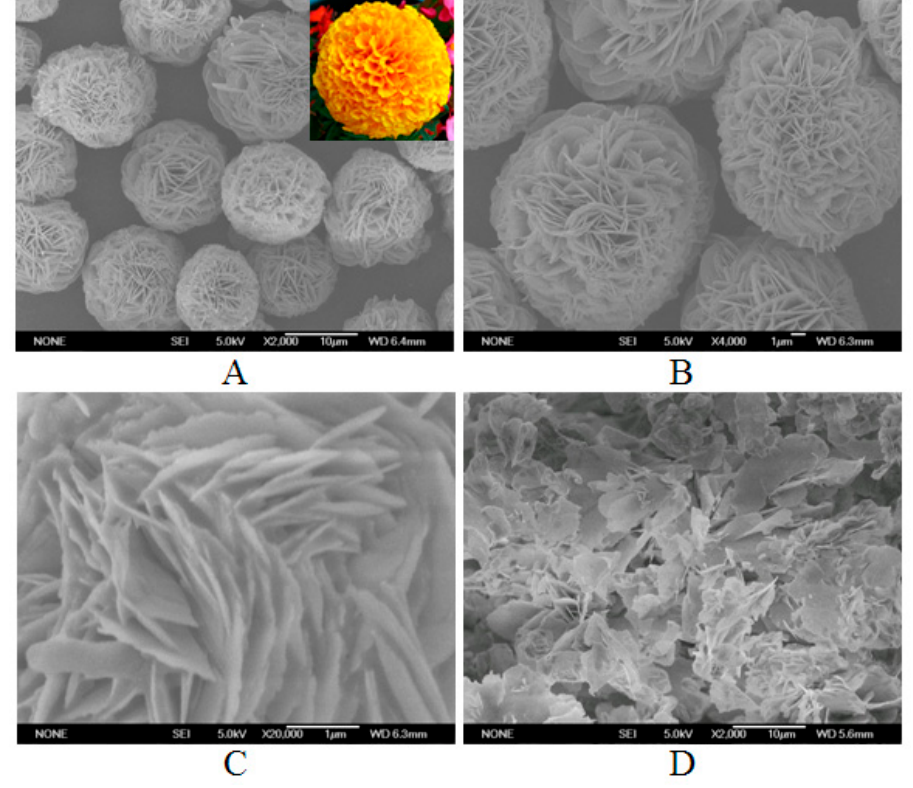
Figure 1. Scanning electron microscope (SEM) of the samples in the presence or absence of laccase. ( A – C ) laccase-incorporated nanoflowers with different enlargement factors. Inset of ( A ) the image of marigold in nature. ( D ) Cu 3 (PO 4 ) 2 ·3H 2 O matrices without laccase.